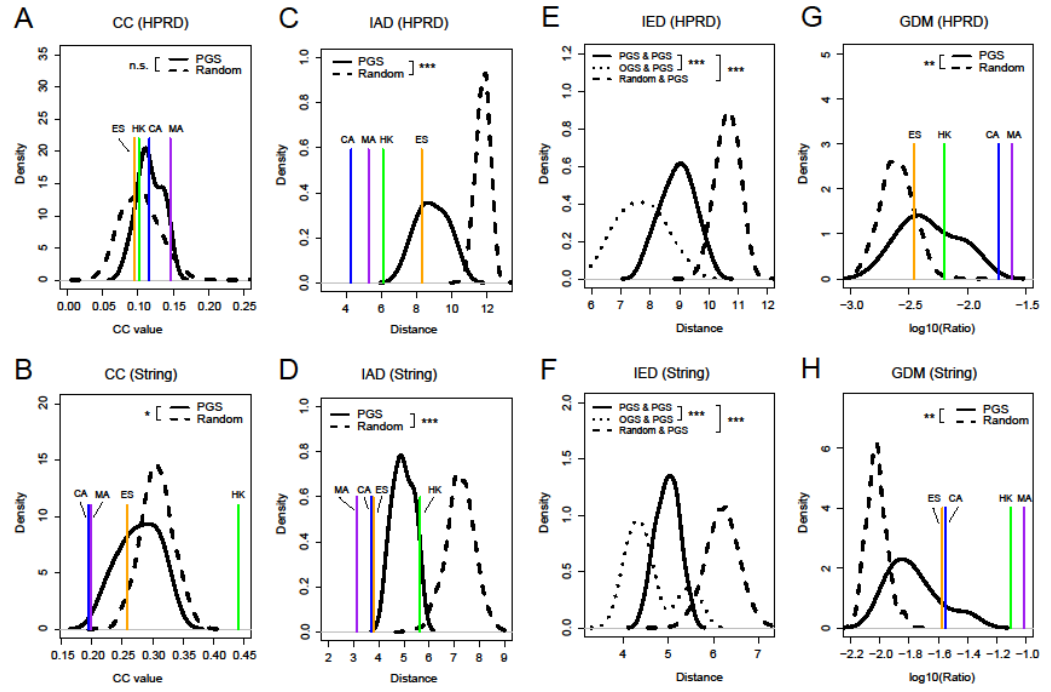
Figure 4. Distributions of clustering coefficient (CC) ( A and B ), intra-set distance (IAD) ( C and D ), inter-set distances (IED) ( E and F ), and genset-distribution in modules (GDM) ( G and H ) of nine prognostic gene sets (PGS), random sets, and four other gene sets for comparison based on the HPRD and String networks. The random sets were sampled from the whole HGNC gene database 1000 times with each sample containing 120 genes. Differences in the distribution of four network properties between PGS and the random gene sets (or other gene sets) were estimated using a one-tailed KS test (triple asterisks, p -value < 0.001; double asterisks, p -value < 0.01; single asterisks, p -value< 0.05; n.s., not significant). In general, four network properties were significantly different between PGS and the random gene sets. Random indicates the random gene sets, OGS indicates other comparable gene sets, namely, CA, MA, ES, and housekeeping gene set (HK). Here, PGS were considered as separate individuals, and “PGS & PGS” indicates IED between one PGS and another.